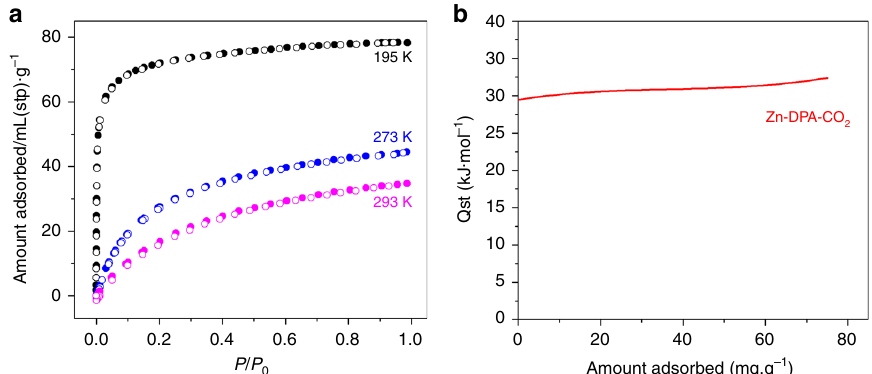
Fig. 2 Isotherms and isosteric heats of CO 2 sorption. a CO 2 adsorption isotherms for Zn -DPA at 195 K (black), 273 K (blue), and 293 K (purple); stp is standard temperature and pressure. b Isosteric heats of CO 2 adsorption for Zn